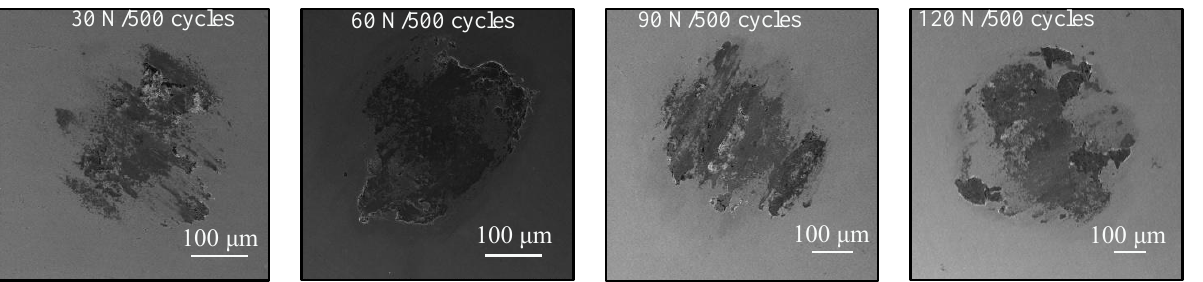
Figure 14. Wear scar of the counterbody against the AlTiN-coated HSS substrate under different conditions.